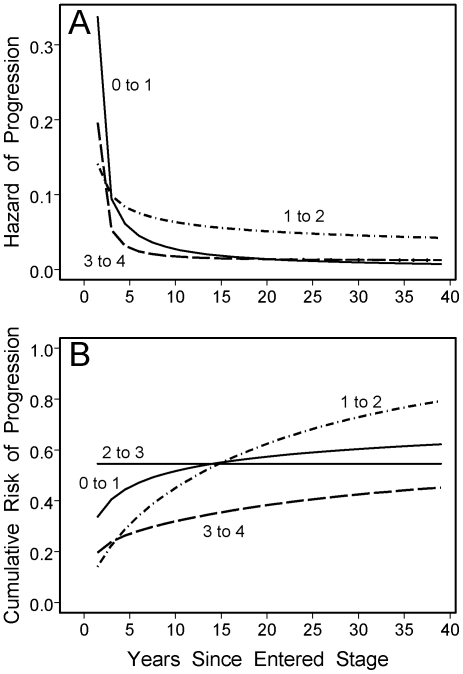
Baseline progression risk for the model in the top part of
Table 4
, for a non-black participant in the San Francisco Veterans Affairs Medical Center liver studies cohort [17].(A) Risk of progression at a time step of 1.5 years given no progression at earlier time steps (hazard of progression). All transitions have decreasing hazard, reflecting the odds ratios <1 in Table 4 for years in stage. For the transition from stage 2 to 3, the estimated hazard of progression is 0.55 for the first step and 0 at all later times; this is not shown to avoid compression of the vertical scale for the other transitions. (b) Cumulative risk of progression. The cumulative risk in the first time step is equal to the hazard; at later time steps, it is equal to the previous cumulative risk plus the current hazard times (1 – previous cumulative risk). The cumulative risk therefore increases by less than the current hazard when the previous cumulative risk is already substantial.